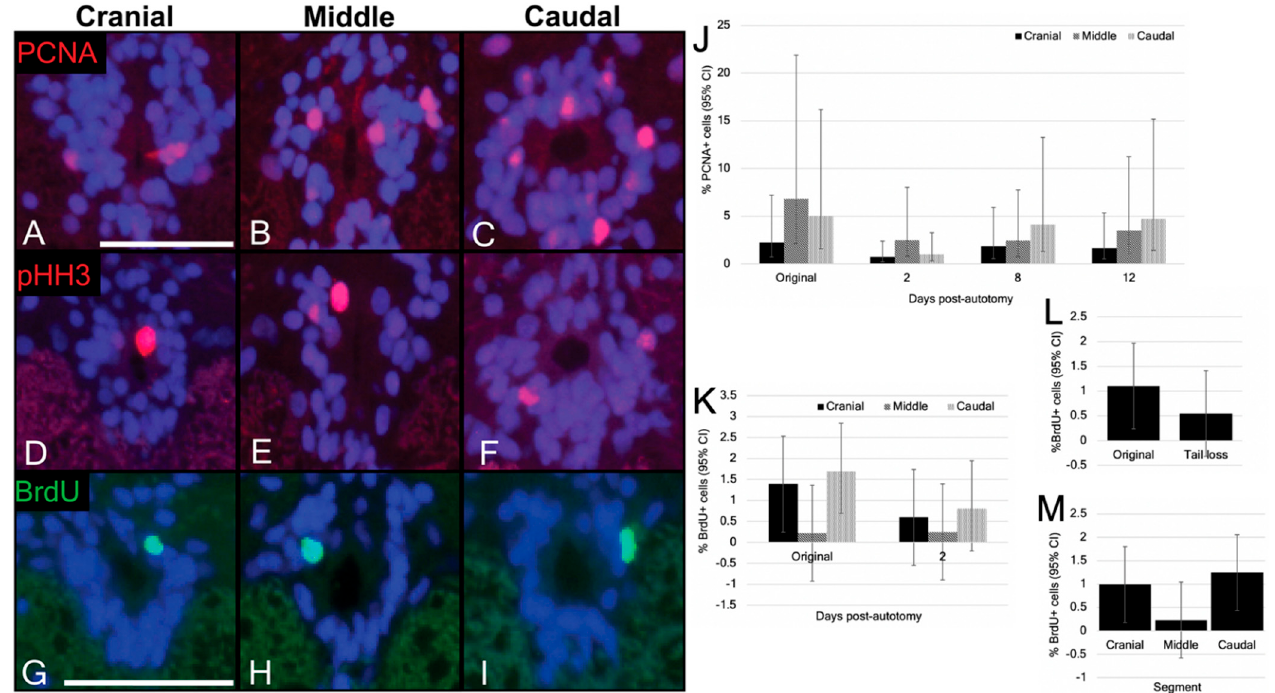
Figure 7. Ependymal cells of the trunk spinal cord constitutively proliferate. ( A – I ) In original tailed geckos, PCNA+ ( A – C ), pHH3+ ( D – F ) and BrdU+ ( G – I ) cells are present within the ependymal layer across all three segments of trunk spinal cord. ( J ) Quantification of PCNA+ ependymal cells across the trunk spinal cord before, 2 days, 8 days and 12 days after tail loss. ( K ) Quantification of BrdU+ ependymal cells across the trunk spinal cord after two-day pulse prior to and following tail loss. ( L ) Quantification of BrdU+ ependymal cells in original tail and tail loss groups. Comparing BrdU incorporation between groups reveals no significant difference in the proportion of BrdU+ cells after tail loss ( p = 0.2785). ( M ) Quantification of BrdU+ cells in each segment of the trunk spinal cord. Combining data across time points reveals there is no segment variation in BrdU staining across the trunk spinal cord ( p values > 0.05). CI = confidence interval. Scale bars: ( A – I ) = 10 µm. Table 3. Proportion of PCNA+ ependymal cells and 95% confidence intervals.